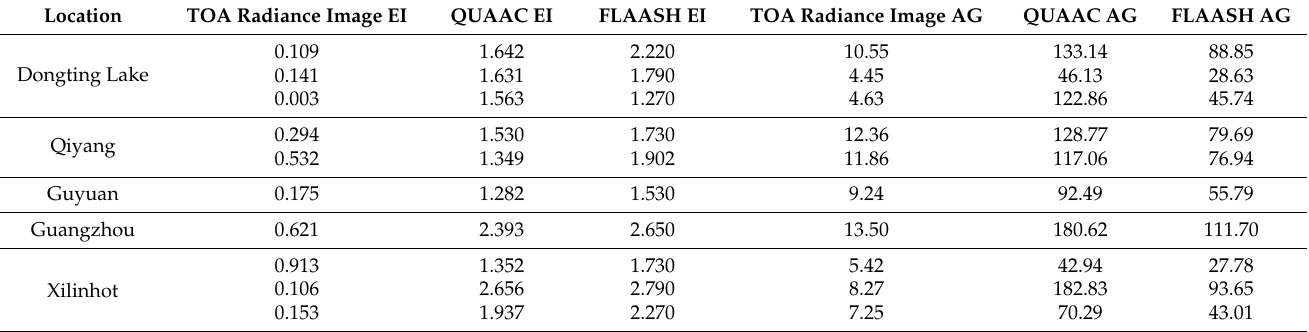
Table 4. Information entropy and average gradient of TOA radiance images, QUAAC − corrected images, and FLAASH − corrected images